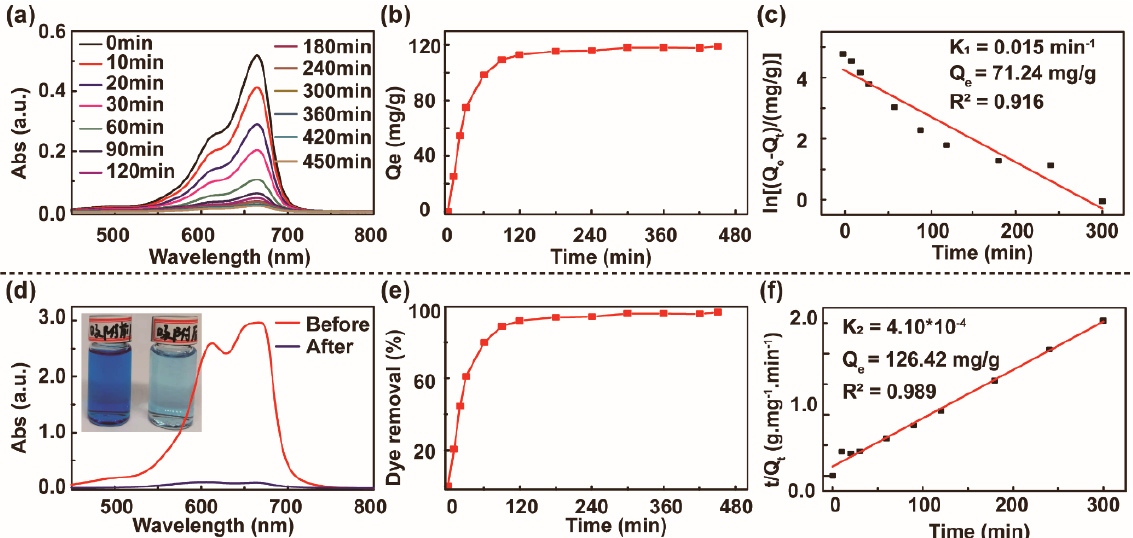
Figure 4. Adsorption performance studies at different times. ( a ) UV–vis spectra of the extract after different adsorption periods (all the extracts were diluted 10 times). ( b ) Diagram of the relationship between time and adsorption capacity. ( c ) Quasi-first-order dynamic model fitting curve. ( d ) UV spectrogram of the extract before and after adsorption, illustrated by comparison photos before and after adsorption. ( e ) Diagram of the relationship between time and removal rate. ( f ) Quasi-second-order dynamic model fitting curve.